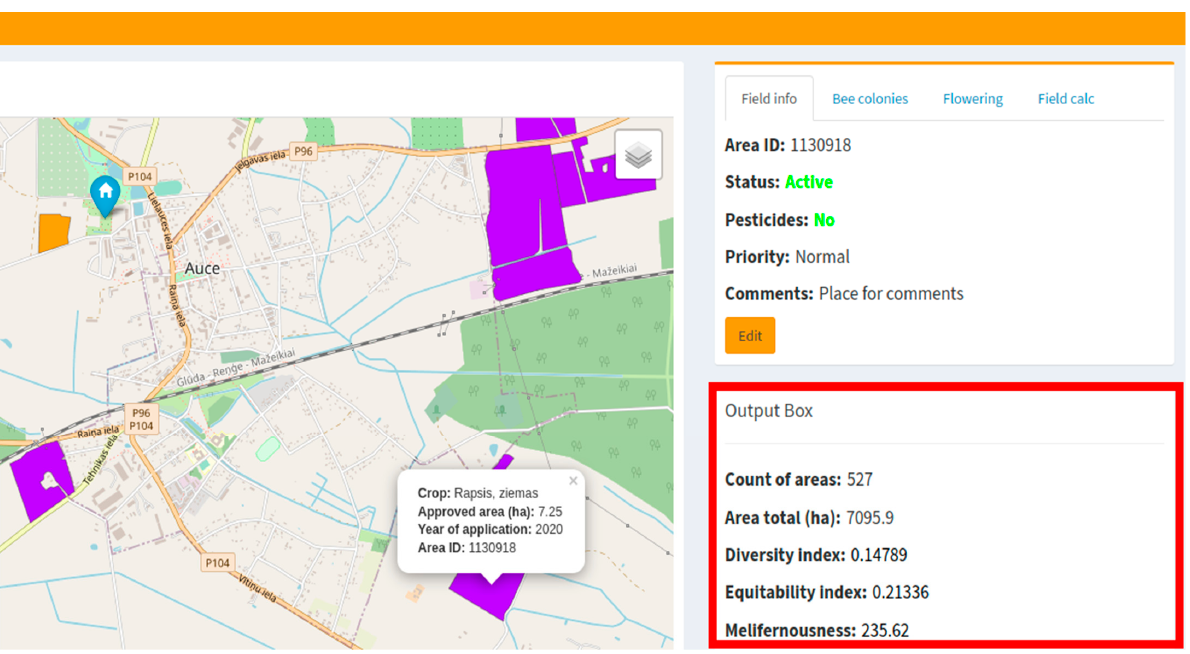
Figure 6. Calculated parameters for the specific field.